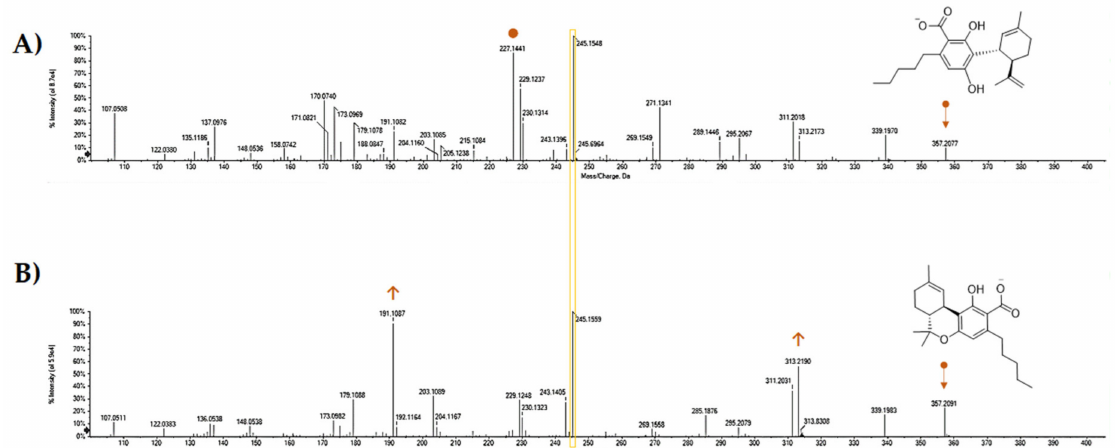
Figure 7. TOF-MS / MS spectra of CBDA (A) and ∆ 9 -THCA (B). Both the compounds, reconstituted in methanol LC-MS grade, at a 10 mg / mL dose level, were analyzed using a Shimadzu NEXERA UHPLC system (Shimadzu, Tokyo, Japan) equipped with a Luna ® Omega Polar C18 column (1.6 µ m, 50 × 2.1 mm i.d, Phenomenex, Torrance, CA, USA). The separation was achieved using a binary solution ( A ) H 2 O (0.1% HCOOH), ( B ) CH 3 CN (0.1% HCOOH) using a gradient program, which started at